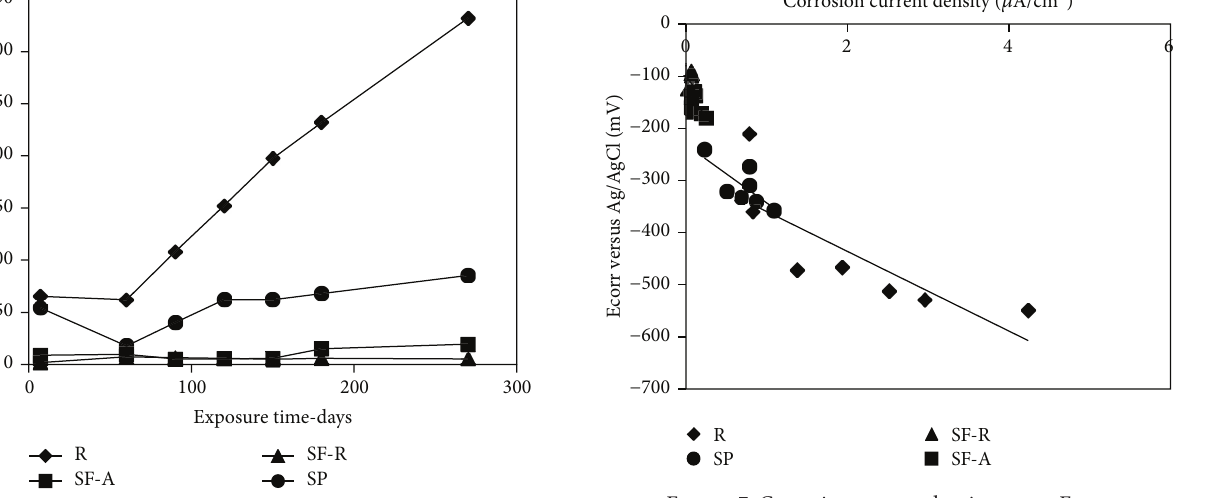
Figure 6: Corrosion currents versus time of exposure.